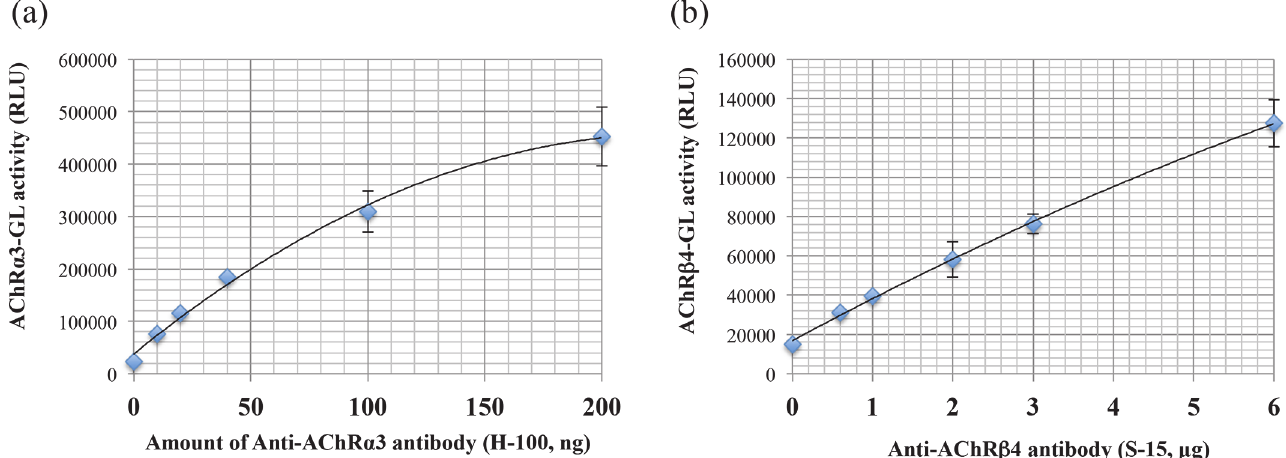
Fig 3. Confirmation of the LIPS assay system for the gAChR α 3 or β 4 with ready-made antibodies. The anti-gAChR α 3 antibody (H-100) and the anti gAChR β 4 antibody (S-15) bound the gAChR α 3-GL and the gAChR β 4 reporters, respectively in a dose-dependent manner (a and b). The X-axis indicates the amount of ready-made gAChR α 3 or β 4 antibody used. The Y-axis indicates the gAChR α 3 or β 4-GL activity. The line with closed diamonds shows the results that were obtained in this